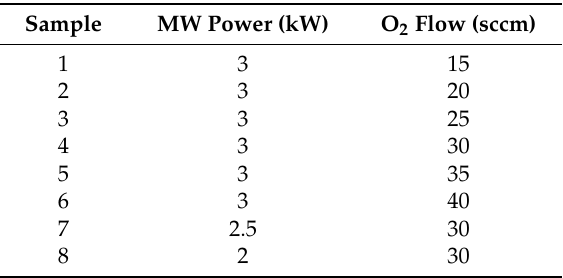
Table 1. List of samples deposited under various conditions.